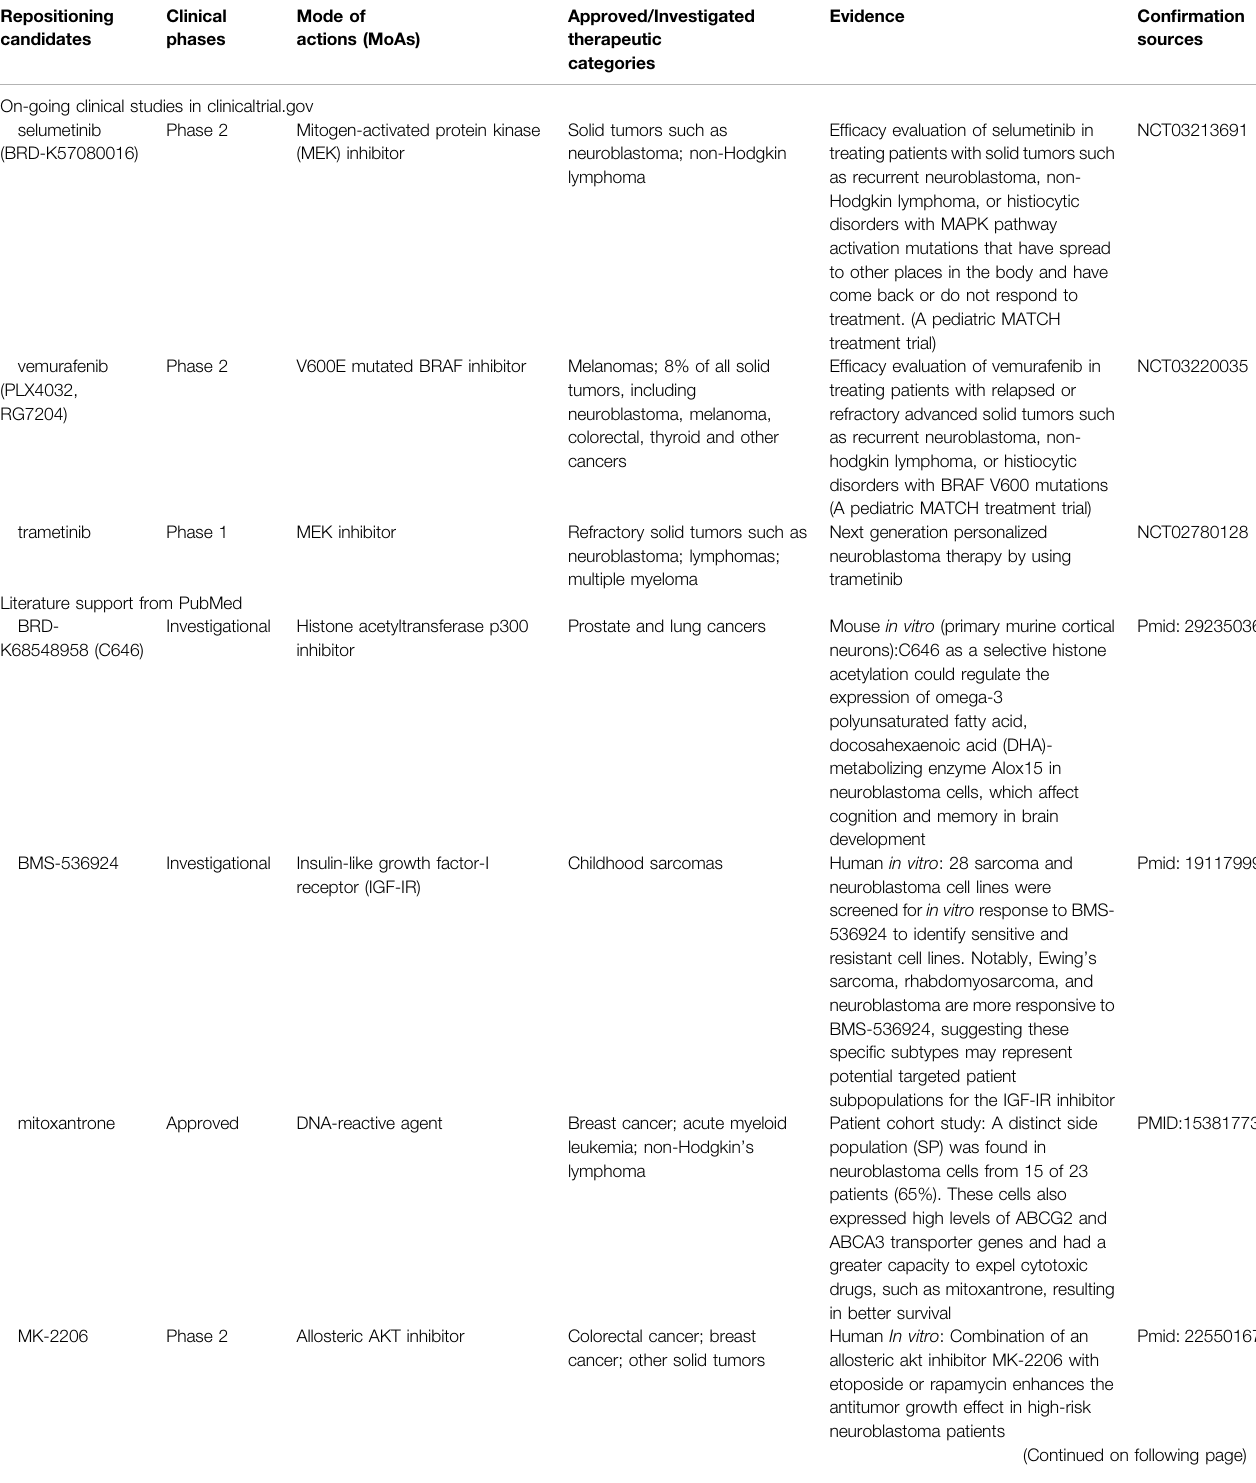
TABLE 3 | Summary information of Repositioning candidates for neuroblastoma patients in re fi ned high-risk